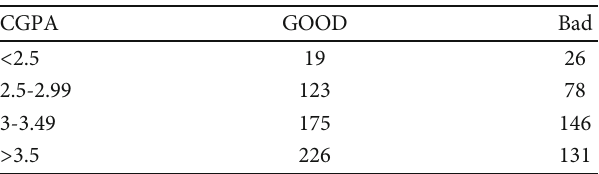
Table 5: Self-reported sleep quality and CGPA, number of students